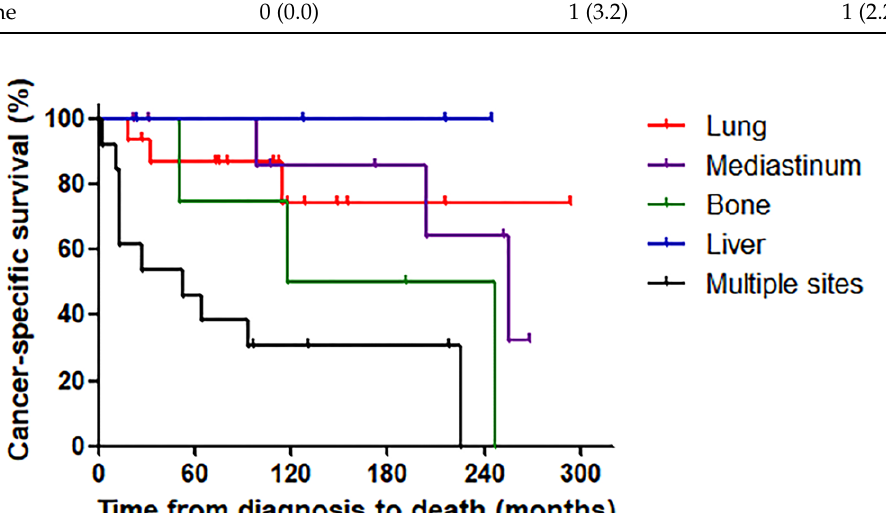
Figure 1. Cancer-specific survival according to initial distant metastasis site (log-rank p = 0.001). The CSS rates of patients with lung metastasis were 100.0% at one year, 87.1% at three and five years, and 74.6% at 10 years. The CSS rates of patients with mediastinum metastasis were 100.0% at one, three and five years, and 85.7% at 10 years. Those of patients with bone metastasis were 100.0% at one and three years, 75.0% at five years, and 50.0% at 10 years, and those of patients with liver metastasis were all 100.0% at one, three, five and 10 years, respectively. Finally, the CSS of patients with multiorgan metastasis was 84.6% at one year, 53.8% at three years, 46.2% at five years, and 30.8% at 10 years. When analyzing the factors affecting the prognosis, age, primary tumor size (>4.0 cm), the presence of initial distant metastasis, and initial distant metastasis site were significant risk factors for CSS. After adjustment for all other variables, the initial distant metastasis site was an independent risk factor for cancer-specific survival (Supplementary Table S1).